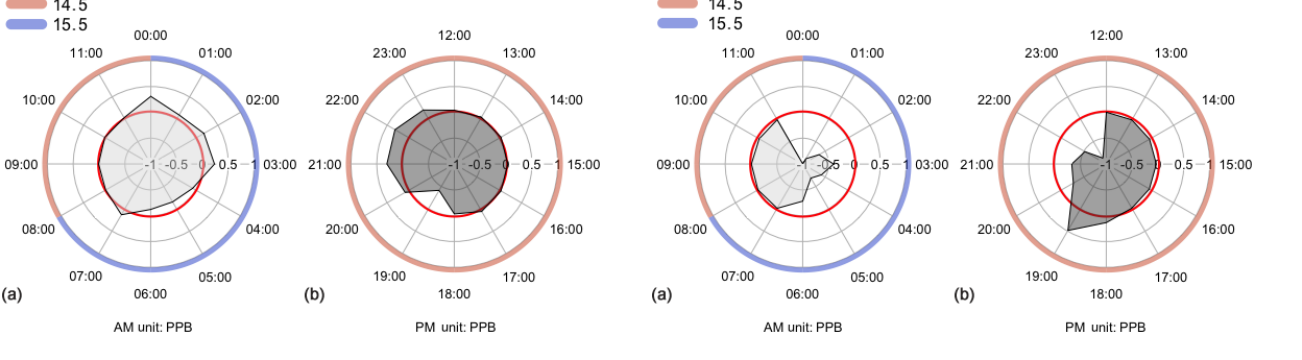
Figure 20. CH 4 mixing ratios difference between HR and HR_RESHIFT in domain 3 for conventional wells. Panel (a) shows the differences between 00:00 and 12:00EST on 14 and 15 May. Panel (b) shows the differences between 12:00 and 24:00EST on 14 May.